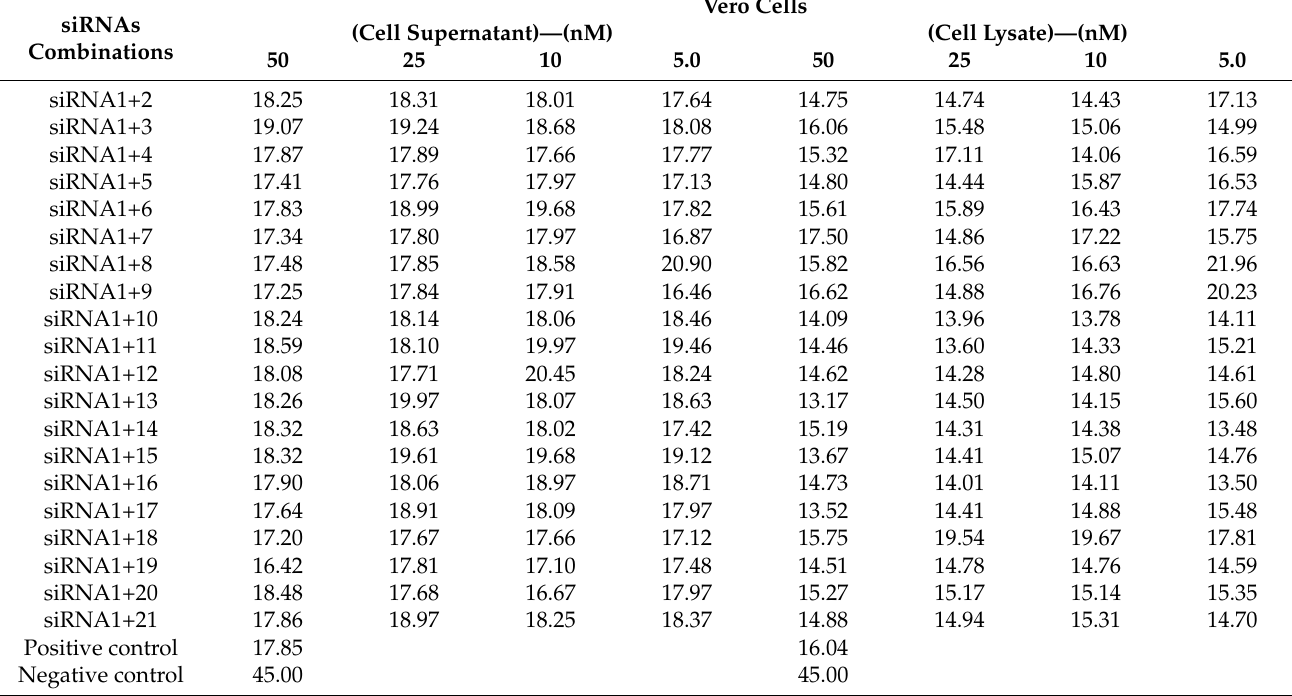
Table 3. Ct value of qPCR of siRNA in Vero